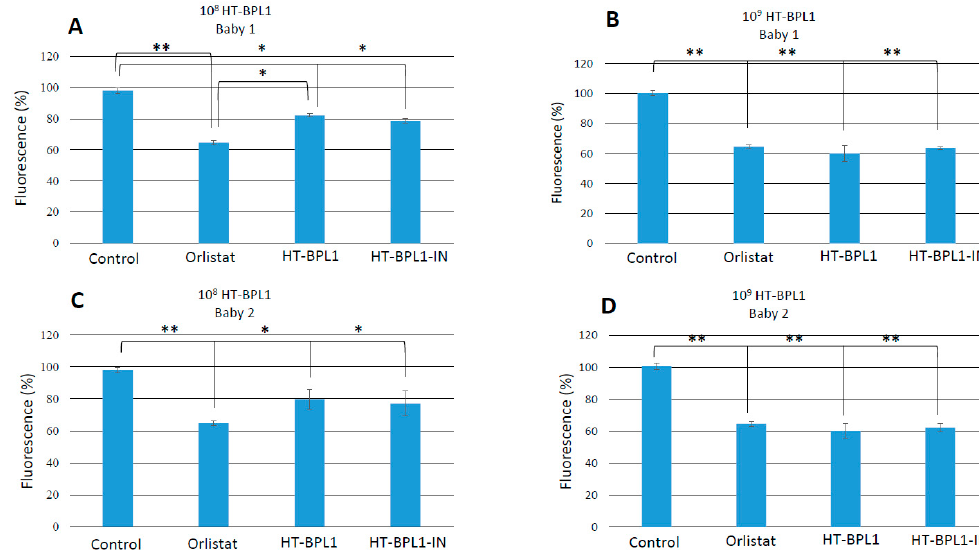
Figure 2. E ff ects of heat treated BPL1 (HT-BPL1) alone, or added on the infant milk formula Innova (HT-BPL1-IN), on fat deposition of C. elegans grown for 3 days on the fermented slurries (24 h) from two di ff erent healthy babies. Fat deposition was monitored with relative fluorescence (ordinates) at the end of the incubation periods, expressed as % reduction of fluorescence compare to control worms (worms grown on DMSO). Antiobesity drug Orlistat was added to a well at 6 µ g / mL as positive control (DMSO, the solvent for Orlistat). ( A , C ) experiments done with 10 8 HT-BPL1 cells / reactor in slurries from babies 1 ( A ) and 2 ( C ). ( B , D ), experiments done with 10 9 HT-BPL1 / reactor with innova milk formula (HT-BPL1-IN) or HT-BPL1 alone, in fermented slurries from baby 1 ( B ) or baby 2 ( D ). Data are mean ± SD of 120 worms per well in each condition * p < 0.05, with respect to control. ** p < 0.001, with respect to control.